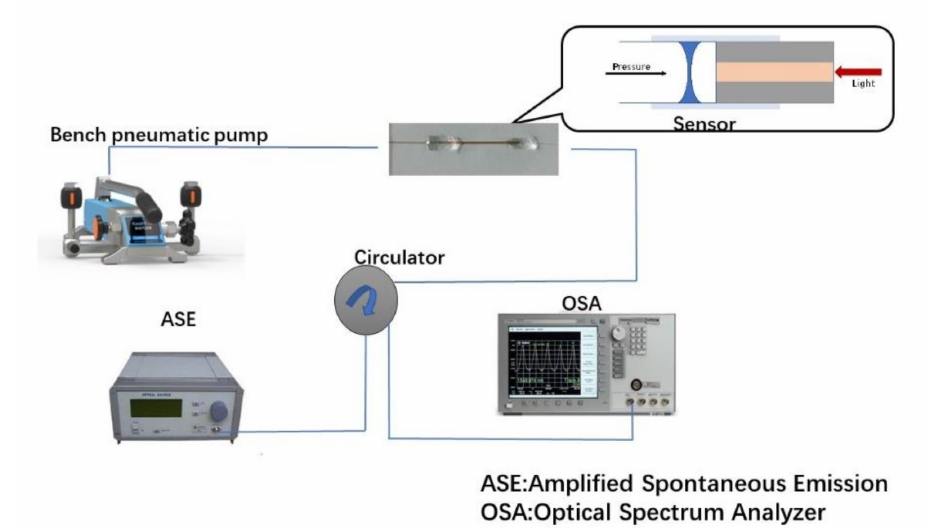
Figure 7. Schematic diagram of experimental test.